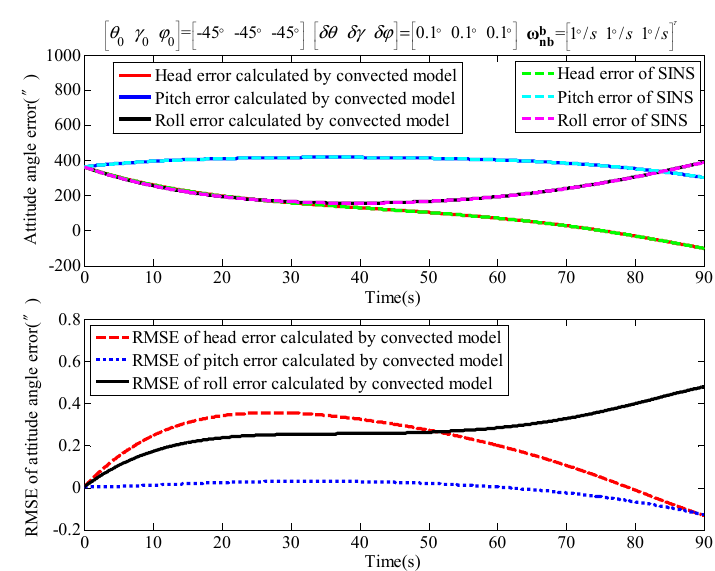
Head error calculated by convected model Pitch error calculated by convected model Roll error calculated by convected model